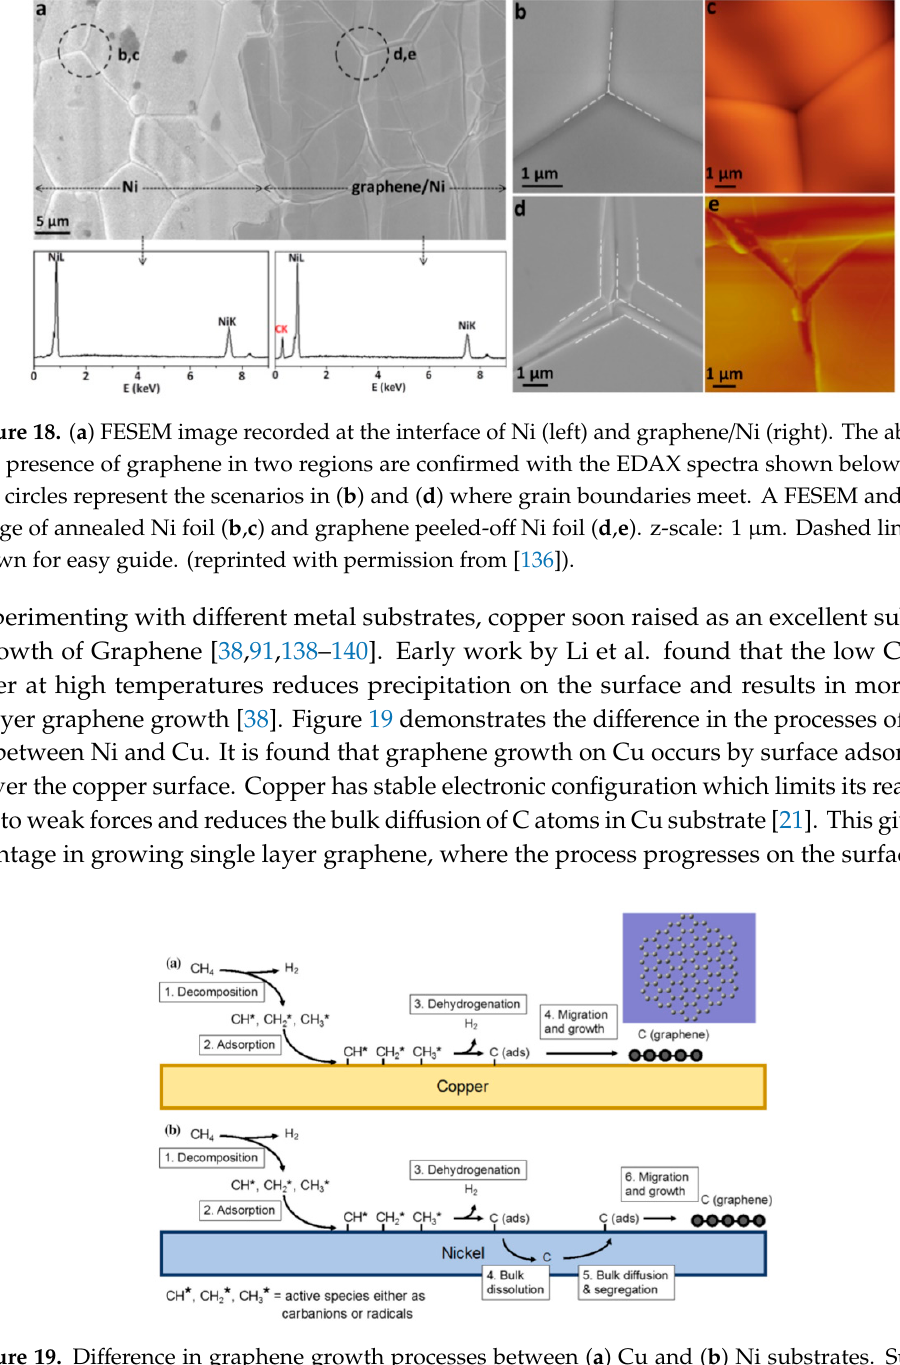
Figure 19. Di ff erence in graphene growth processes between ( a ) Cu and ( b ) Ni substrates. Surface di ff usion occurs on Cu substrate while bulk di ff usion and precipitation occurs on Ni (reprinted with permission from